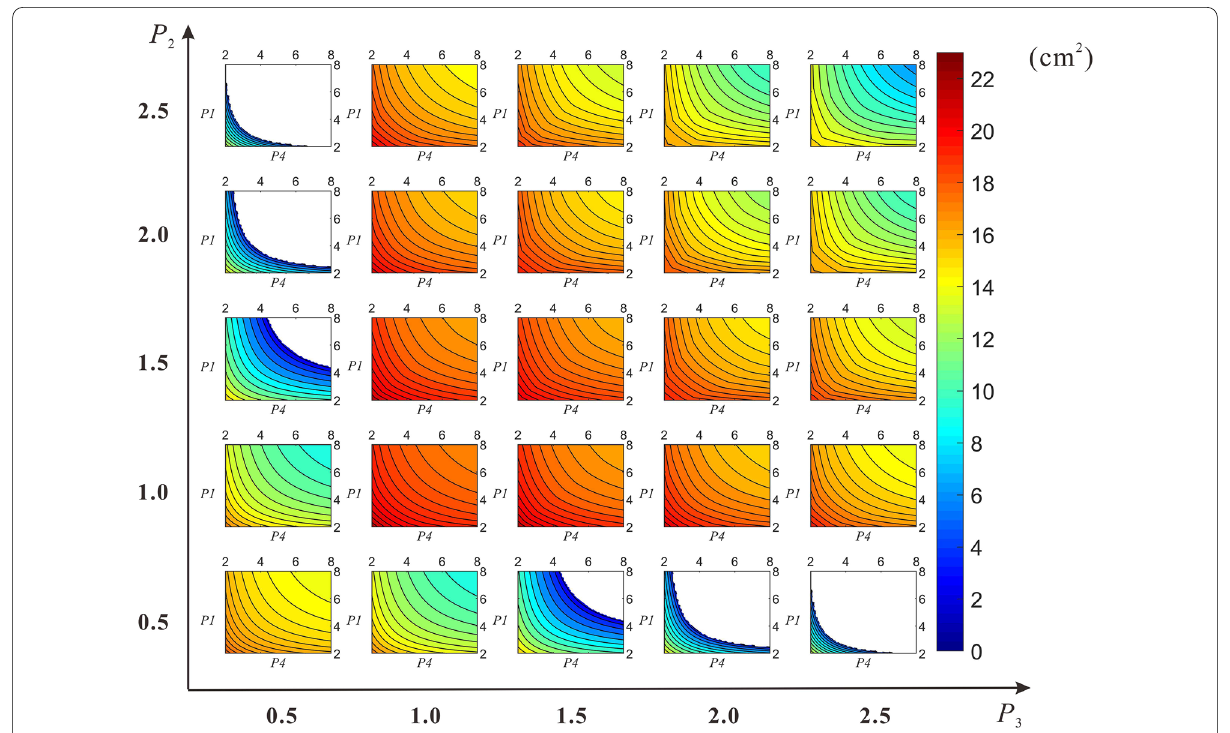
Figure 4 Maximum workspace of the palm with different P